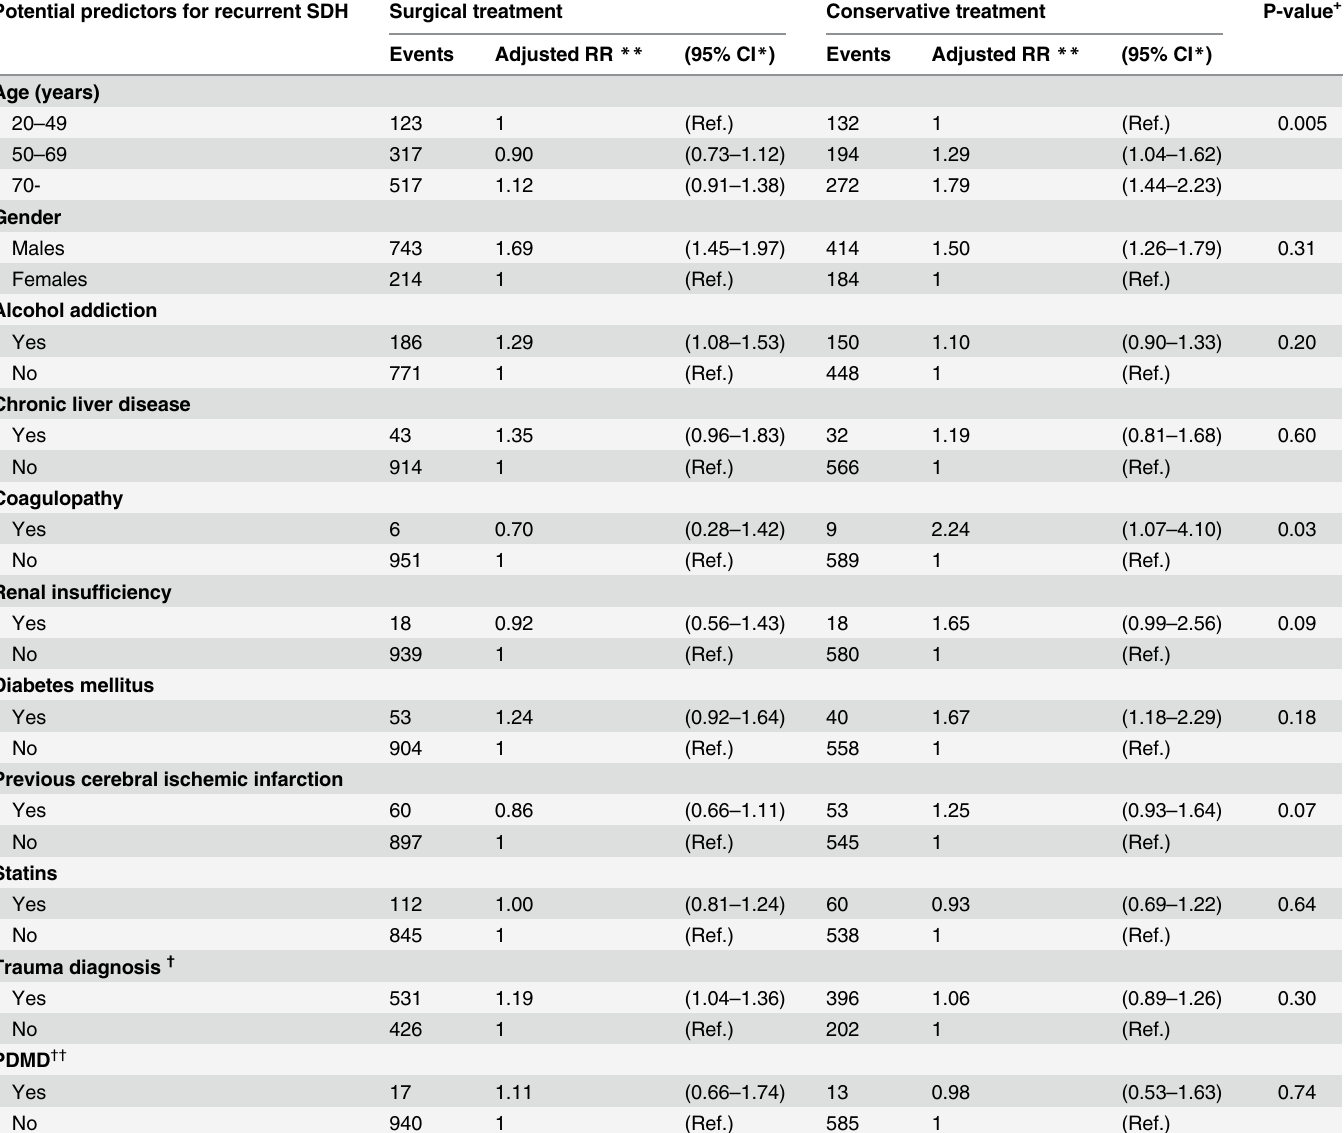
Table 3. Rate ratio (RR) of recurrent subdural haematoma (SDH) in surgically- and conservatively treated patients, according to potential predic- tors in Denmark 1996 – 2011.